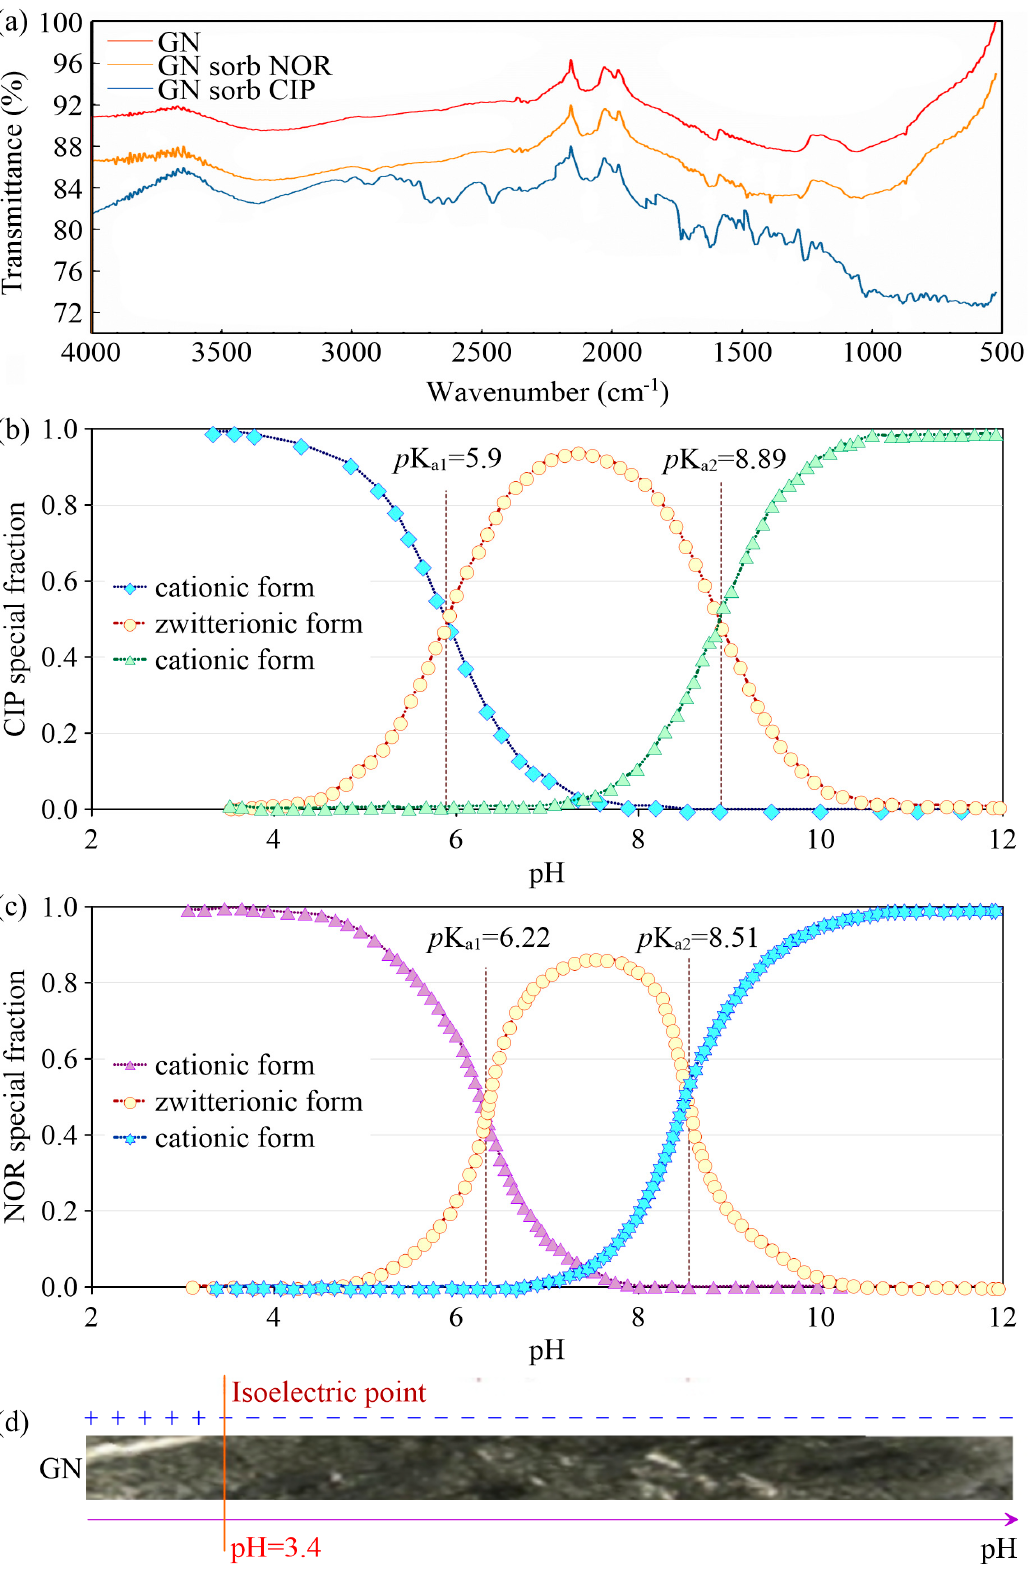
Figure 3. ( a ) Fourier transform infrared spectroscopy (FTIR) of GN before and after CIP/NOR adsorption; ( b ) the existence form of CIP under different pH; ( c ) the existence form of NOR under different pH; ( d ) isoelectric point of GN.